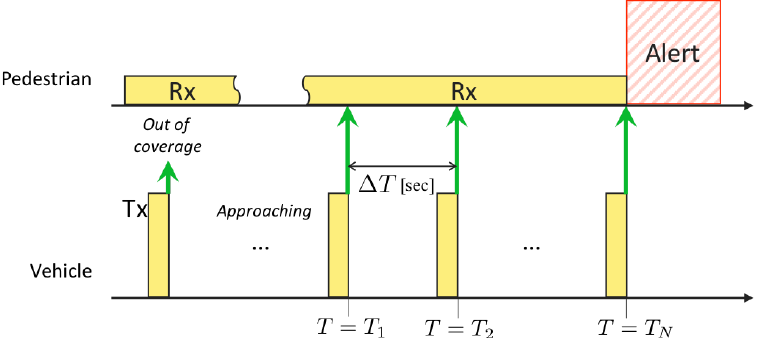
Figure 2. A sequence diagram of the approach detection based on the passive